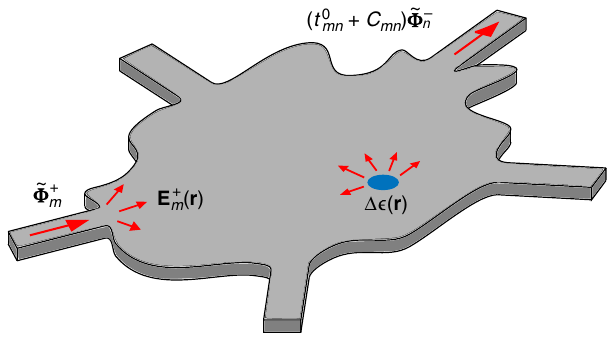
Fig. 1 Illustration of the problem. An m -th ingoing waveguide mode e Φ þ m excites an arbitrary photonic system containing a perturbation Δ ϵ , yielding the total fi eld E þ m . The transmission coef fi cient to the n -th outgoing mode e Φ (cid:2) t ¼ t 0 þ C t 0 fi cient in the mn mn , where mn mn is the transmission coef n is unperturbed system and C mn the coupling coef fi cient induced by scattering by the perturbation. The perturbation map is obtained by scanning the perturbation over the photonic